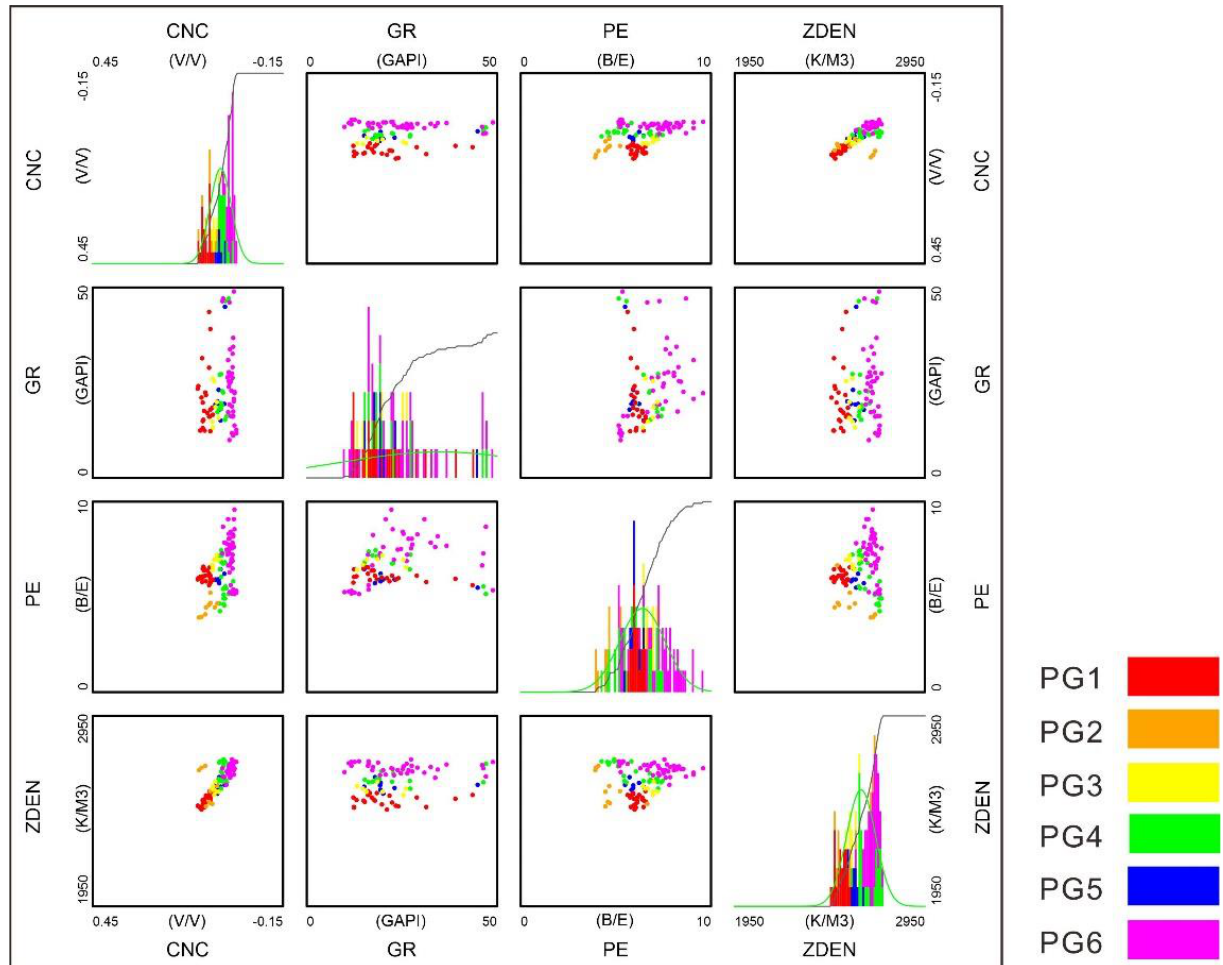
Figure 8. Log response for different petrophysical facies.